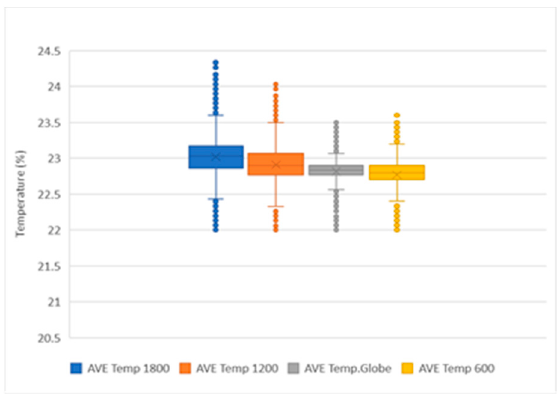
Figure 23. Box and whisker plot of temperature observations during test 2.